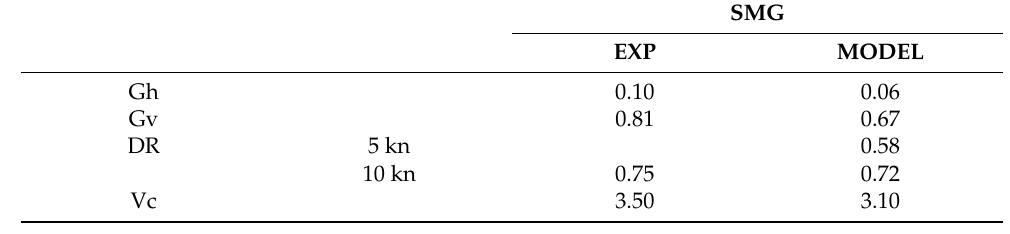
Table A1. Linear stability indexes validation.